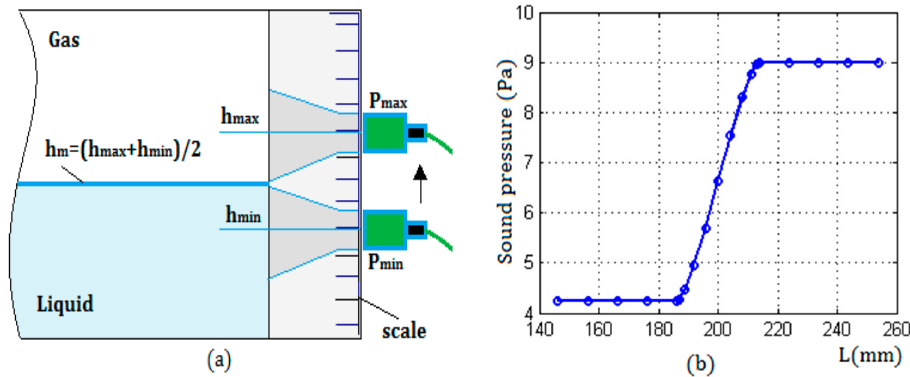
Figure 11. ( a ) The method for determining the liquid level: P max and P min were the echo sound pressure corresponding to the two critical positions respectively; h max and h min were scale values associated with P max and P min ; h m is the height of the measured liquid level; and ( b ) is a sample of the changing characteristics of the echo sound pressure measured by using a transducer with the radius a = 10 mm, the wall thickness L = 25 mm, and the liquid was water.